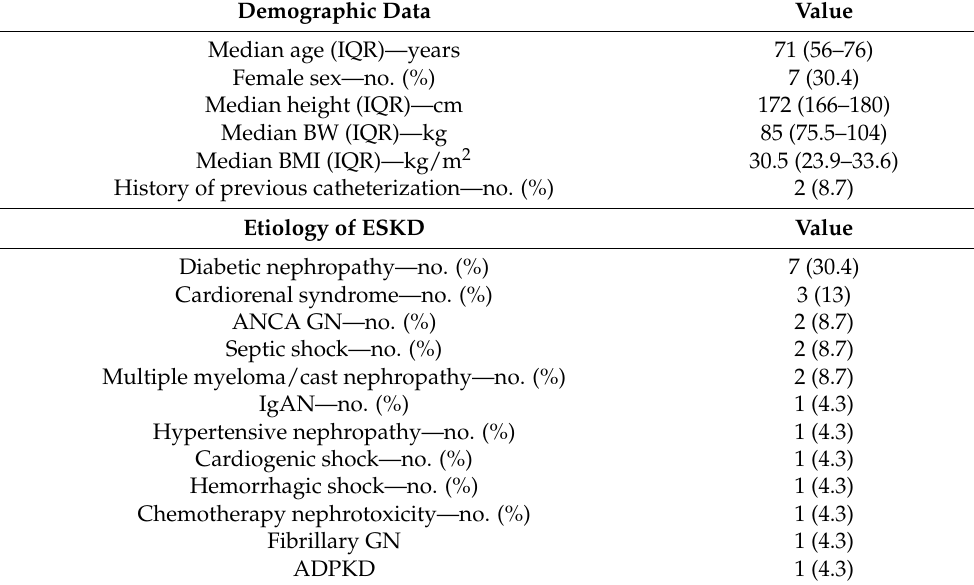
Table 1. Clinical parameters in the total cohort of 23